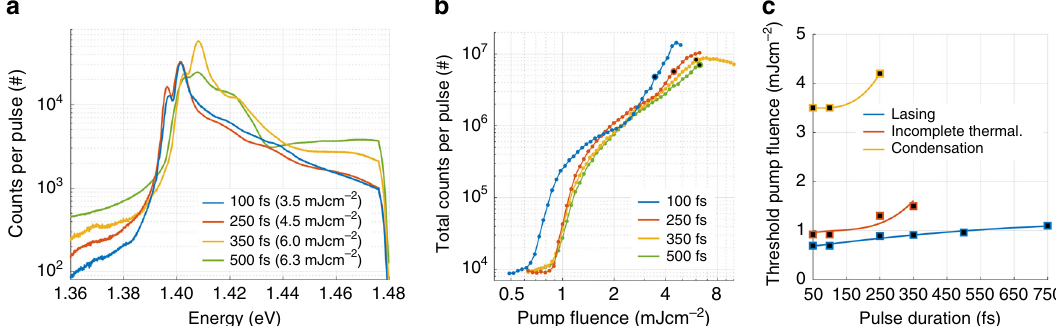
Fig. 7 Line spectra and threshold pump fl uences for different pulse durations. a Line spectra for different pulse durations. Condensation occurs for 100 and 250 fs pulses, but not for longer ones. For the 100 and 250 fs pulses, the spectra are shown at the condensation threshold (3.5 and 4.5 mJ cm − 2 , respectively). The threshold in case of the 100 fs pump pulse is the same as for the 50 fs pulse. We have de fi ned the condensation threshold such that a narrow peak is observed at the band edge together with a linear distribution at high energies in the time-integrated signal. For a 350 fs pulse no condensation is observed, but we show a spectrum for which the tail of the distribution is closest to linear (at 6.0 mJ cm − 2 ). For a 500 fs pulse the spectrum is shown at the highest measured pump fl uence (6.3 mJ cm − 2 ). b Total luminescence intensity as a function of pump fl uence. Increasing the pump pulse duration increases slightly the fi rst (lasing) threshold, whereas the second (condensation) threshold is visible only for the 100 and 250 fs pulses. For the 350 fs pulse, we increased the pump fl uence up to 10 mJ cm − 2 , after which the nanoparticle array starts to damage, to con fi rm that no condensation threshold occurs even at higher fl uences. Rather a saturation and degradation of the luminescence signal can be observed. The highlighted data points correspond to the line spectra in a . c Threshold pump fl uence for lasing and condensation, as well as the beginning of the incomplete stimulated thermalization regime, as a function of pulse duration. In the lasing regime, there is one spectral intensity maximum corresponding to the band edge (this is the lasing peak), and another one (smaller in intensity) at higher energy. First, for increasing pump fl uence, the lasing peak grows and the higher energy peak diminishes. At a certain pump fl uence, however, the higher energy peak starts growing. We determine this pump fl uence value from the line spectra and de fi ne it as the threshold for the incomplete thermalization regime. At this pump fl uence, the interference patterns (such as in Fig. 2e) become visible in the real space spectra. The lines are guides to the